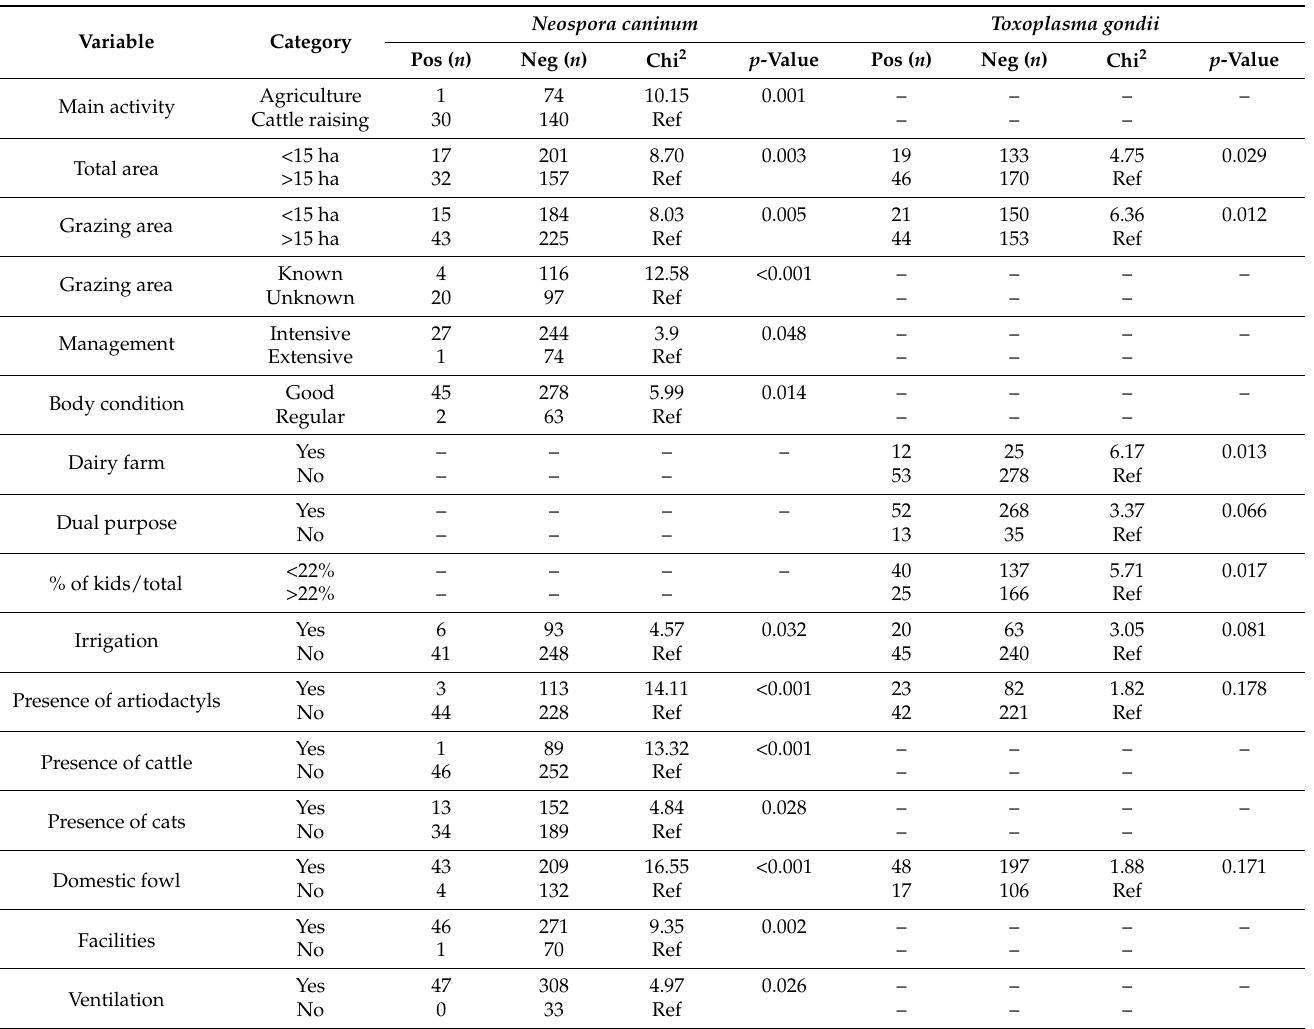
Table A2. Univariable analysis of variables associated with Neospora caninum and Toxoplasma gondii infections in goats from Zapotillo Canton,